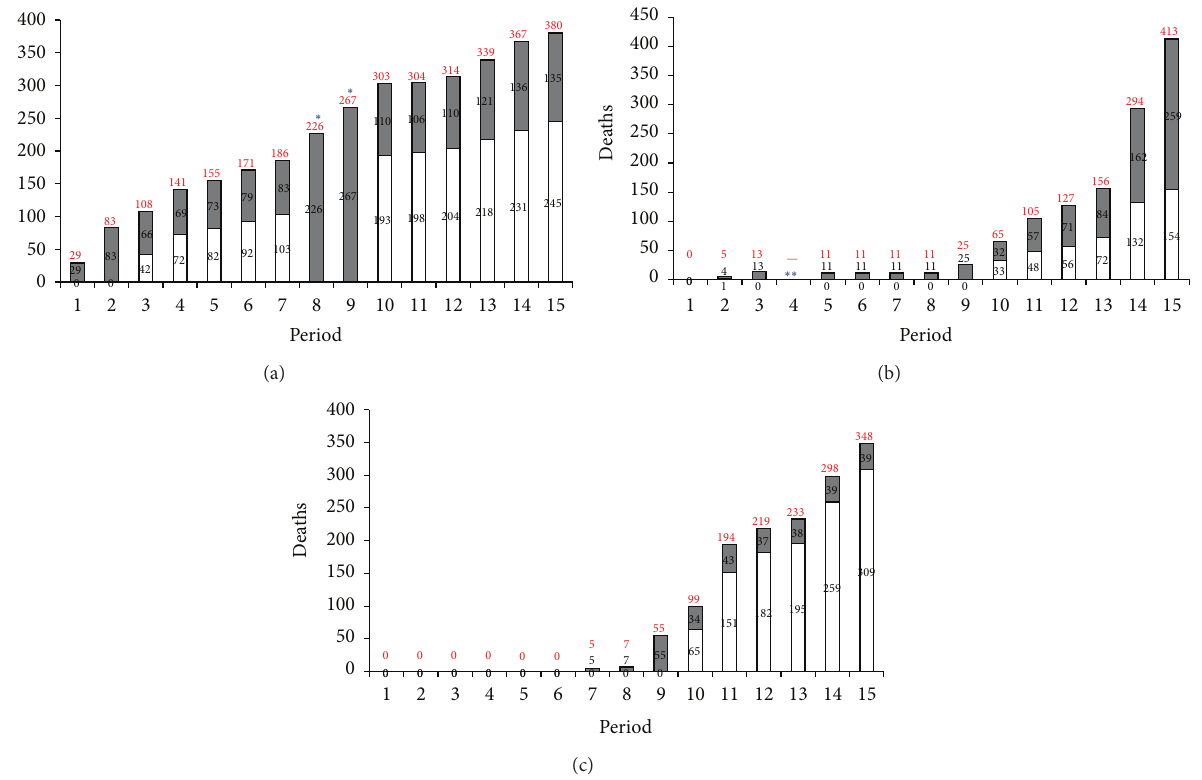
Figure 3: Time trend of compatible EVD deaths (confirmed, white bars; probable and suspected, grey bars) in affected countries Guinea (a), Liberia (b), and Sierra Leone (c) according to the periods reported in Table 1. Red numbers over each bar represent the total amount of all compatible deaths (confirmed, probable, and suspected) for each period. ∗ in (a) indicates that in the relative WHO reports the distinction between confirmed and unconfirmed cases was not made. ∗∗ in (b) indicates that in the relative WHO report notices about the cases progression in Liberia were not reported.